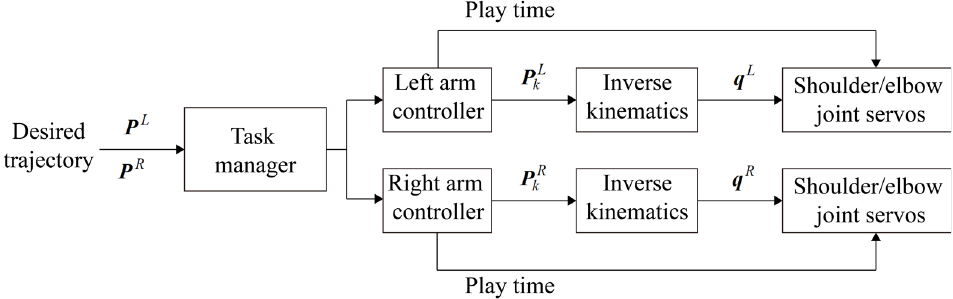
Figure 6. Schematic diagram of arm control structure.